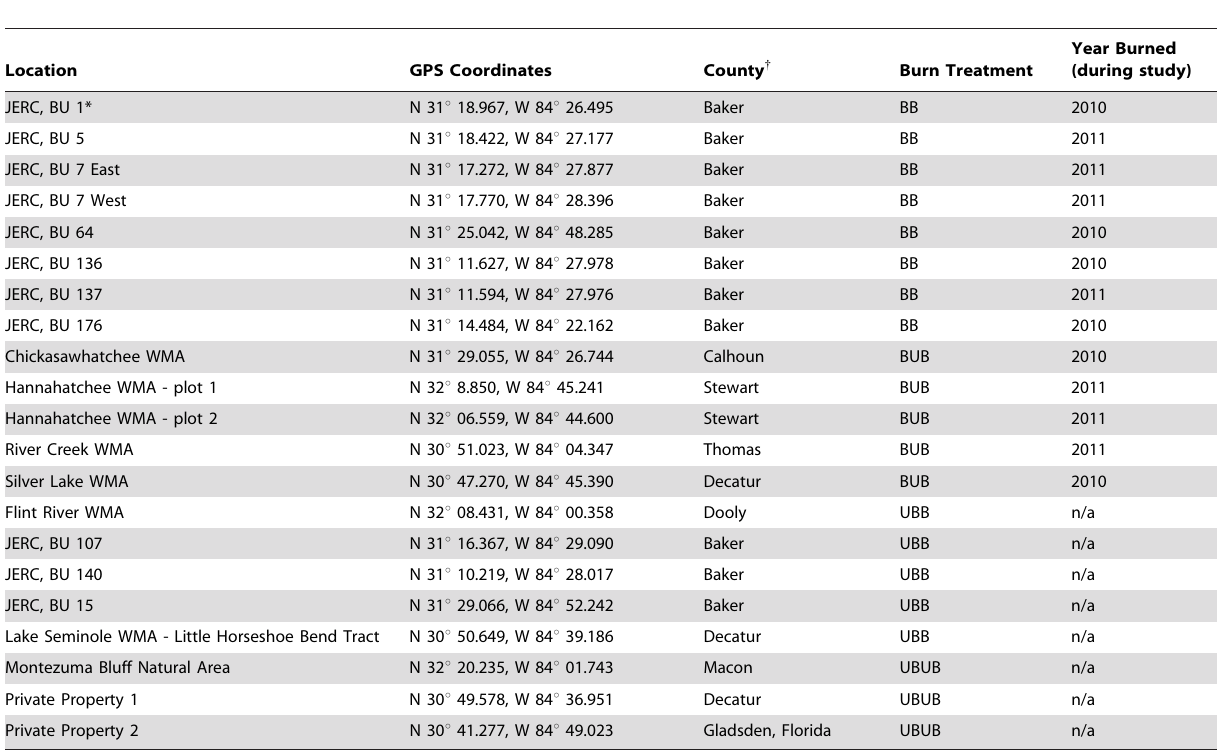
Table 1. Locations and burn data for the 21 plots sampled during this